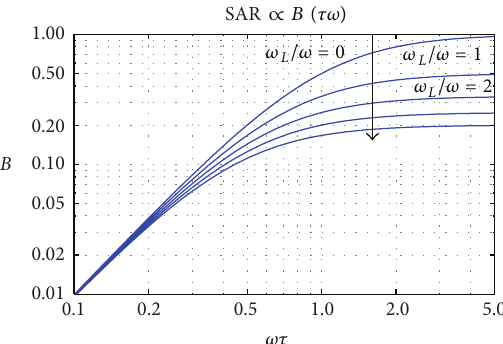
Figure 4: (colour online) The dependence of 𝐵 ∝ SAR, the specific absorption rate on 𝜔𝜏 for various 𝜔 𝐿 /𝜔 ratios from 0 to 4 . See